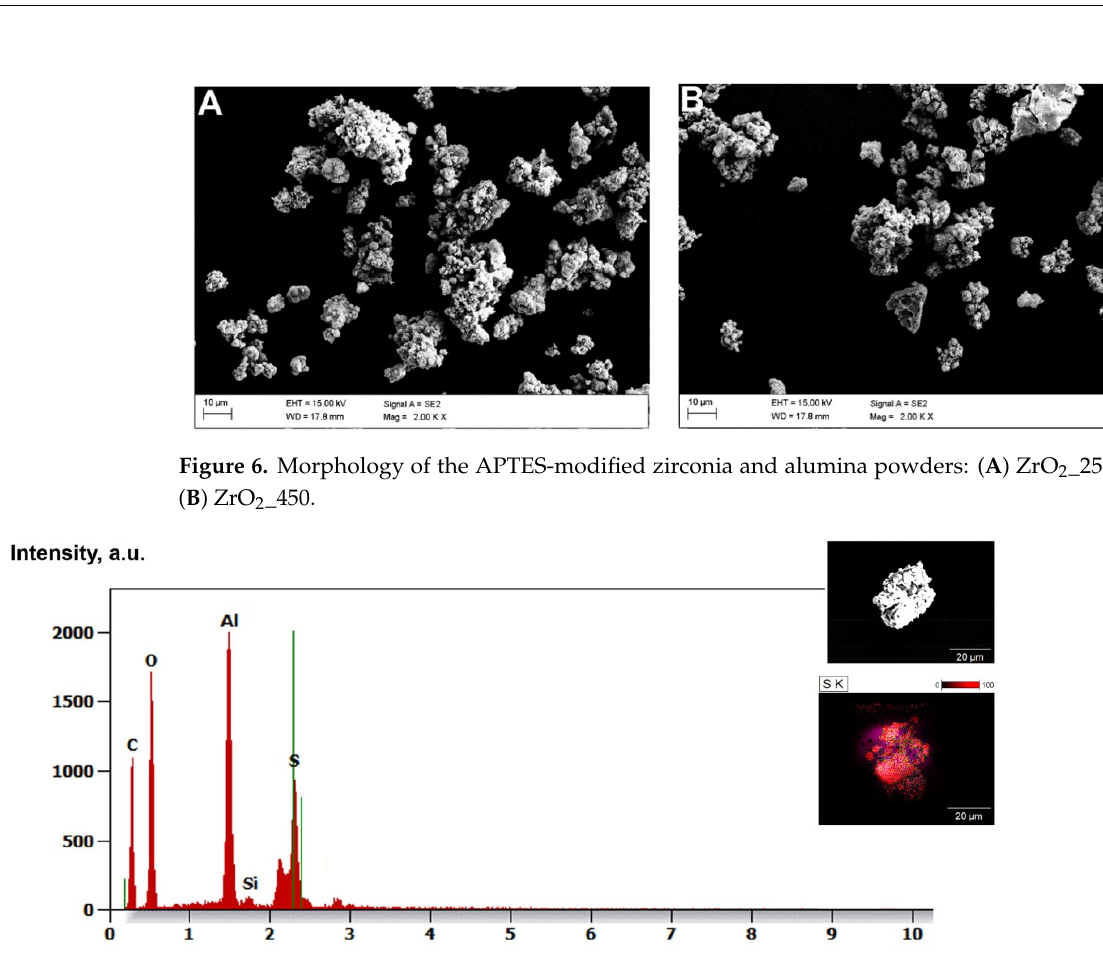
Figure 5. Morphology of the APTES-modified zirconia and alumina powders: ( A ) ZrO 2 _0 and ( B ) Al 2 O 3 _0.